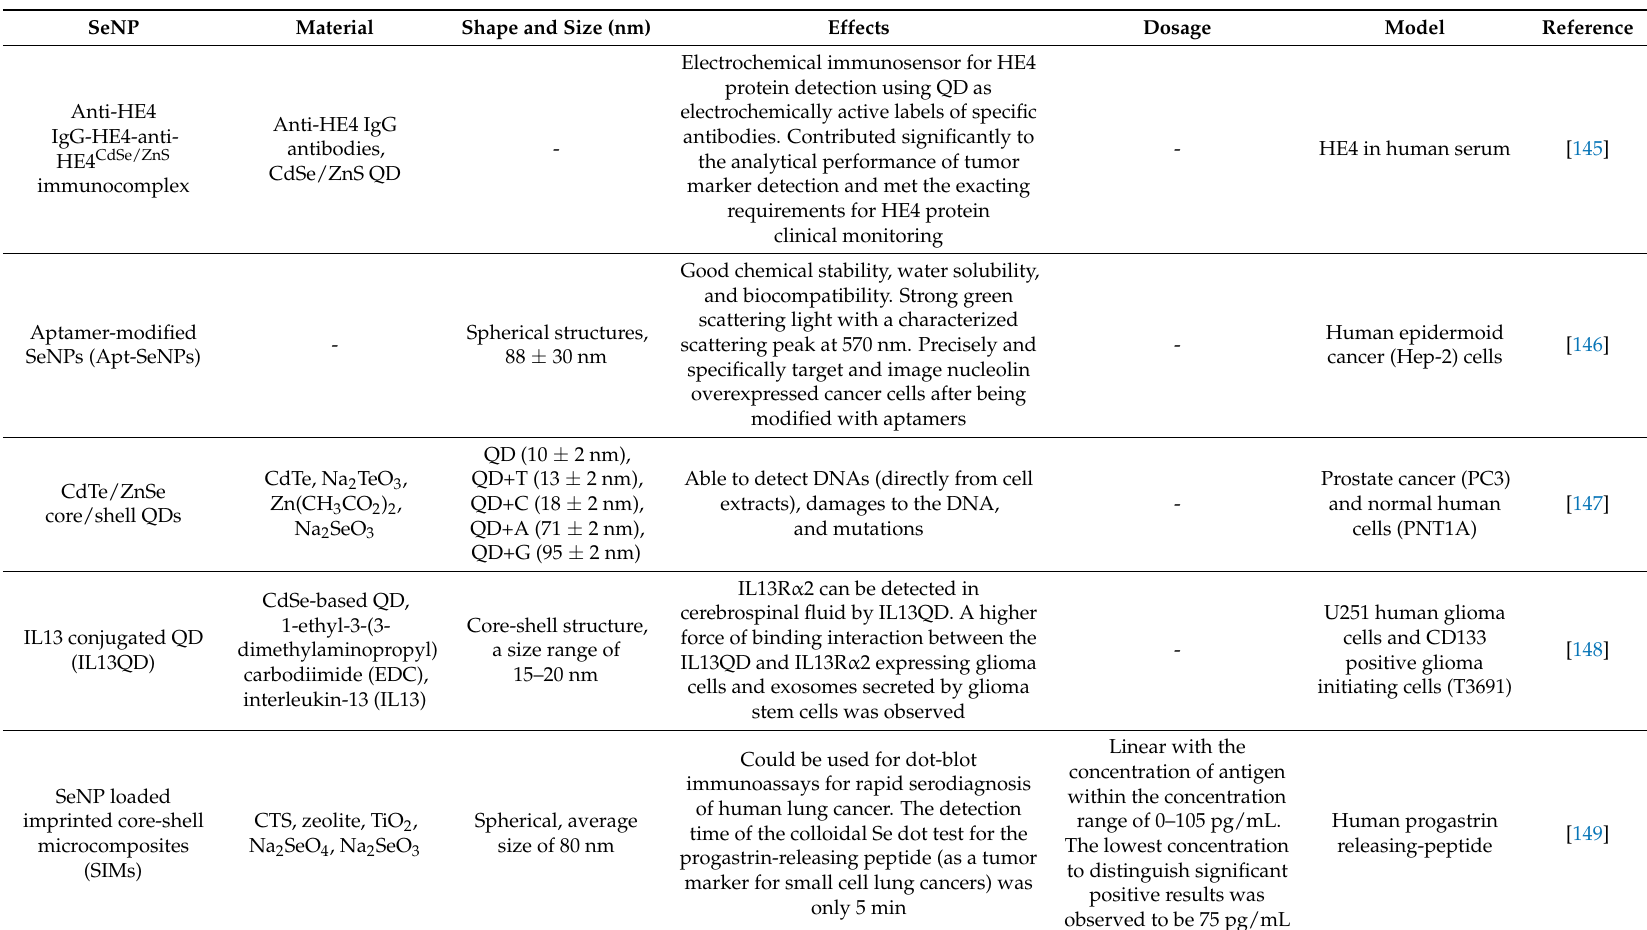
Table 3. Summary of recent work on SeNPs with potential in cancer